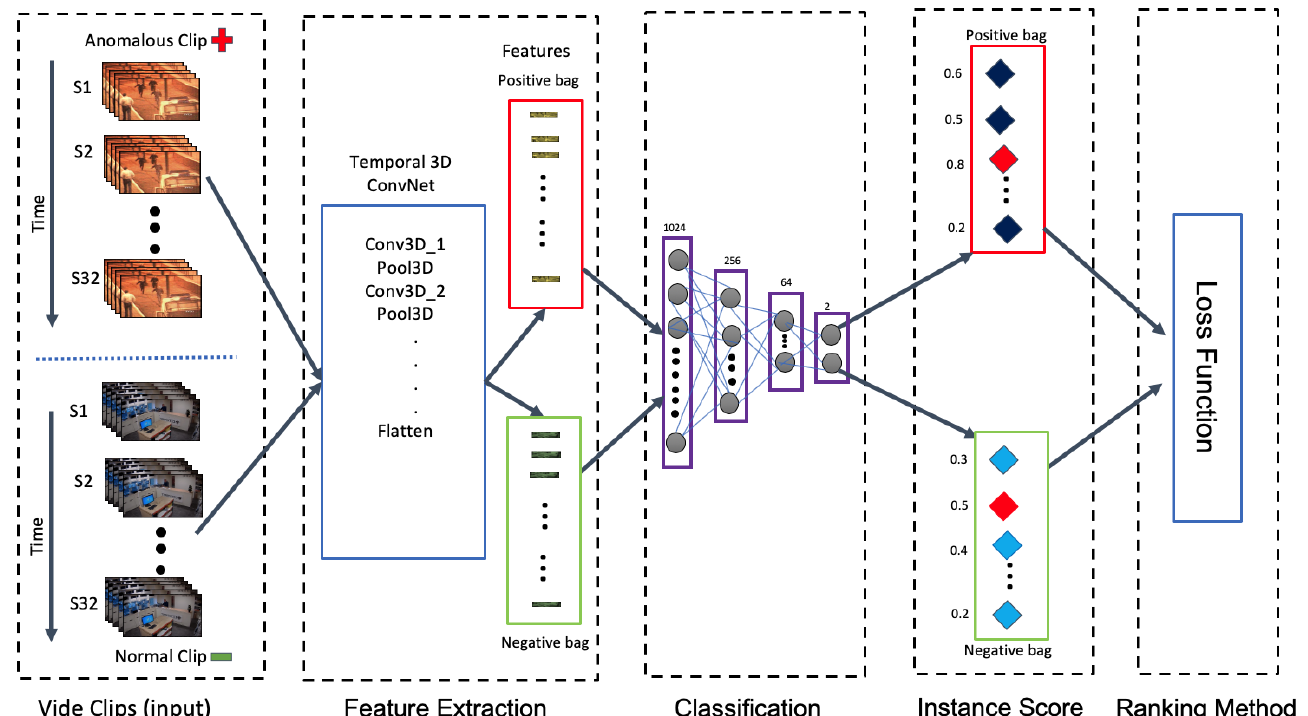
Figure 1. Proposed architecture for anomaly detection in surveillance